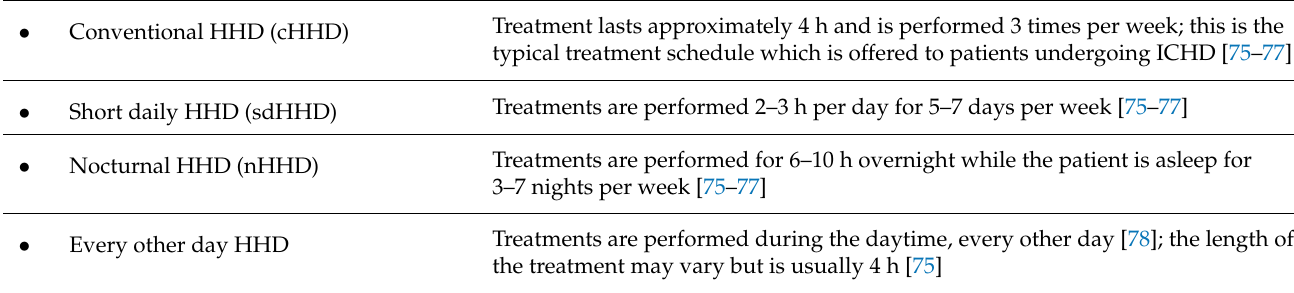
Table 1. Example of selected HHD treatment